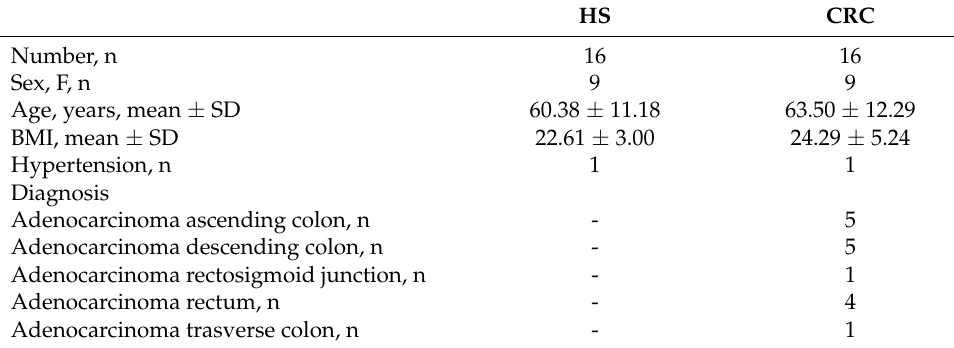
Table 1. Demographic and clinical features of colorectal cancer (CRC) patients and healthy con- trols